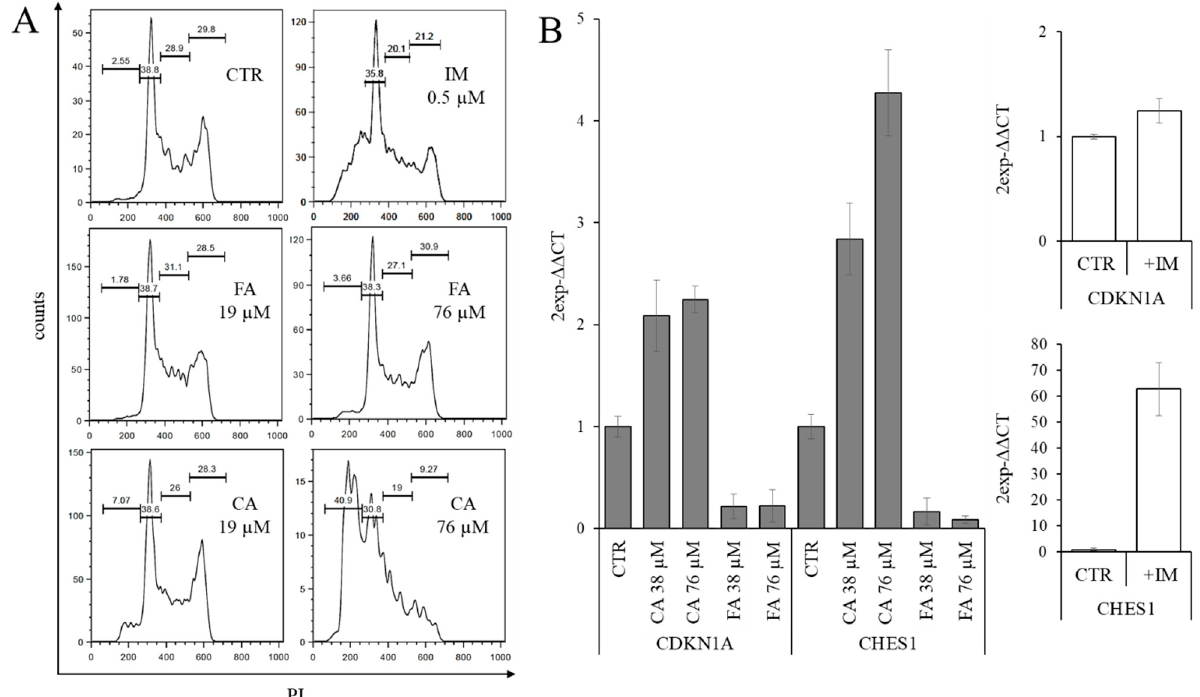
Figure 2. Effects of caffeic acid, ferulic acid and imatinib mesylate on cell cycle progression in K562 cells. ( A ) Effect on cell cycle distribution. The cells were cultured in complete medium for three days in the presence of the indicated compound. After staining with propidium iodide (PI), the cells were analyzed by flow cytometry. CA, caffeic acid; FA, ferulic acid; IM, imatinib mesylate. ( B ) RT-qPCR analysis of the expression of genes coding for cell cycle inhibitory proteins on the second day of treatment with the indicated concentration of CA or FA, or with 0.5 µM IM. CTR, untreated cells. The results were expressed as arithmetic mean ± standard deviation.